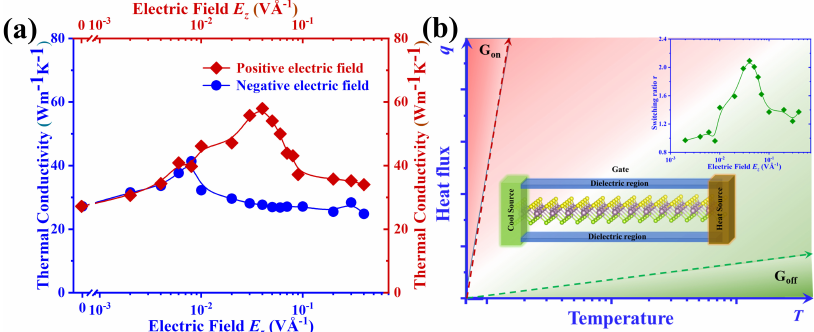
Fig. 2 The asymmetric behavior of thermal transport modulated by electric fi eld. a The thermal conductivity at 300 K under the positive and negative external electric fi elds ranging from 0 to 0.4 VÅ − 1 . b The schematic diagram for the ECTS (Inset: the tunable switching ratio as a function of external electric fi